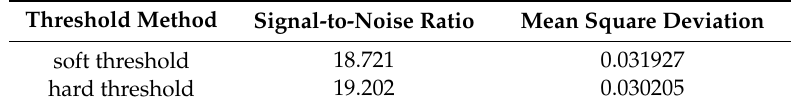
Table 2. The signal-to-noise ratio and the mean square deviation of L cr wave after denoising.